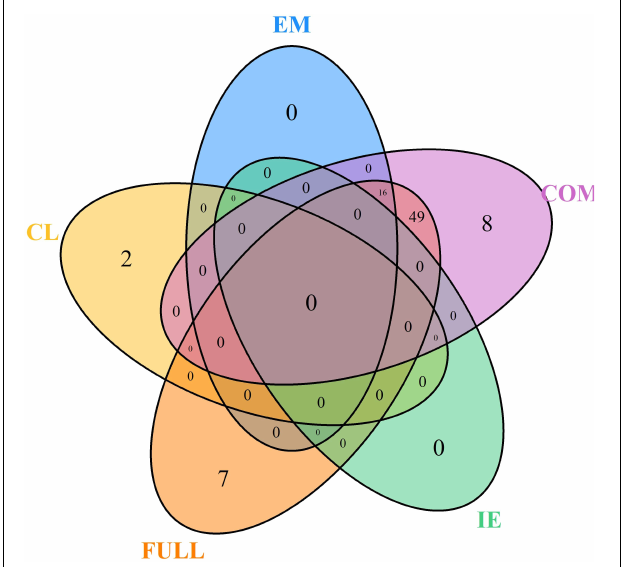
FIGURE 5 | Venn diagram for the number of unique significant markers across the multi-trait genome-wide association studies (MT-GWASs) for seedling emergence (EM), coleoptile length (CL), and the joint analysis for seedling emergence and coleoptile using the full effect (FULL), interaction effect (IE), and common effect (COM) multi-trait mixed models for identifying significant loci controlling deep-sowing seedling emergence and coleoptile length in a Pacific Northwest winter wheat diversity panel (DP) phenotyped across trials from 2015 to 2019 in Lind, WA.